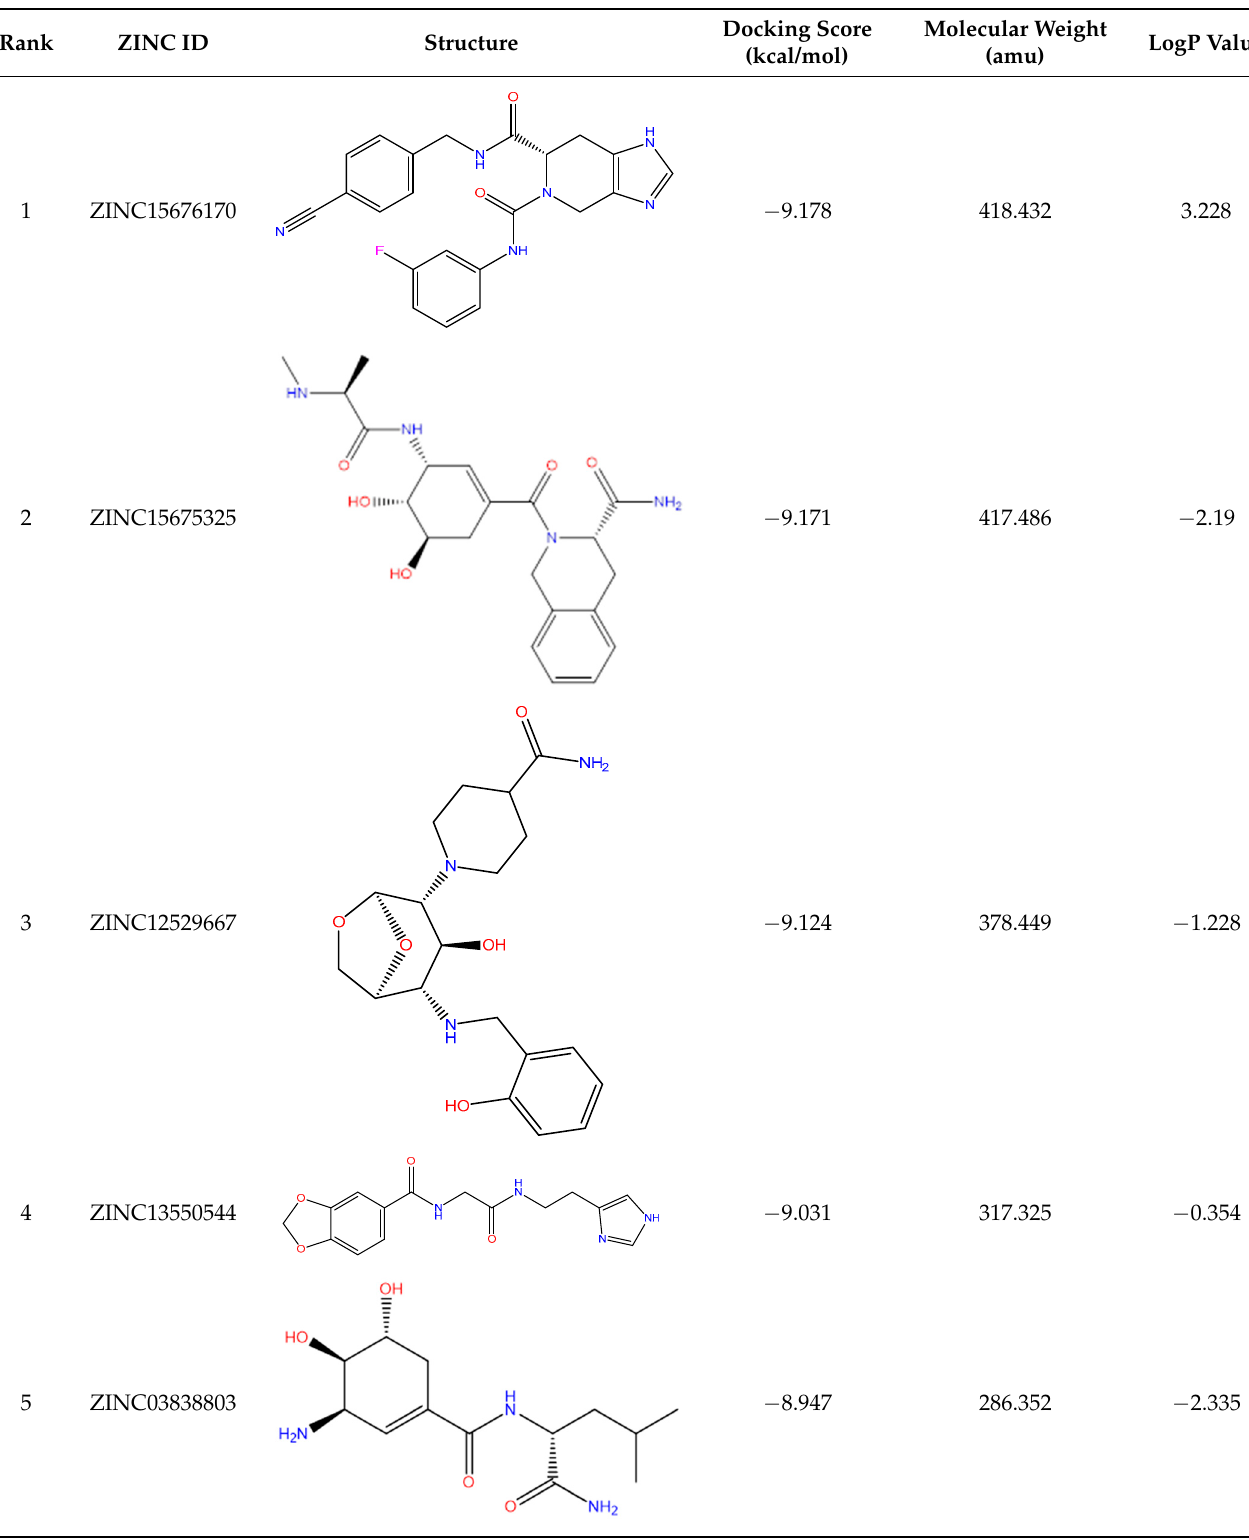
Table 1. Top 10 ligands with the best docking scores predicted by Glide.